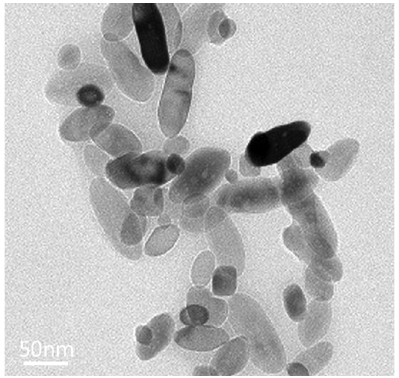
Figure 6: TEM pictures of products synthesized with hexylamine with Ti ( SO 4 ) 2 as a titanium source.